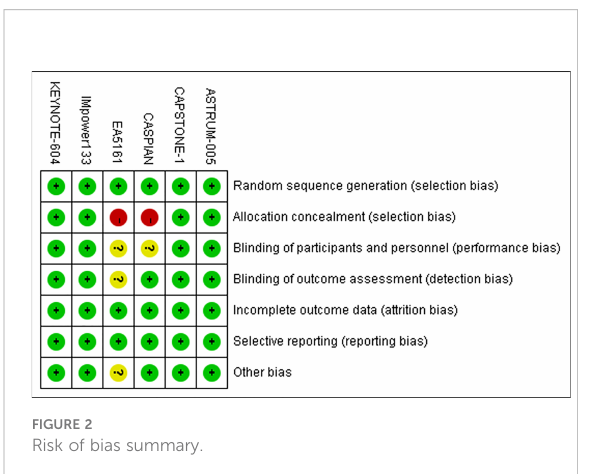
FIGURE 2 Risk of bias summary.